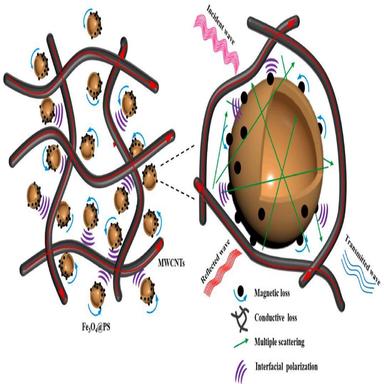
Microwave absorption mechanism of Fe3O4@PS/MWCNT samples.